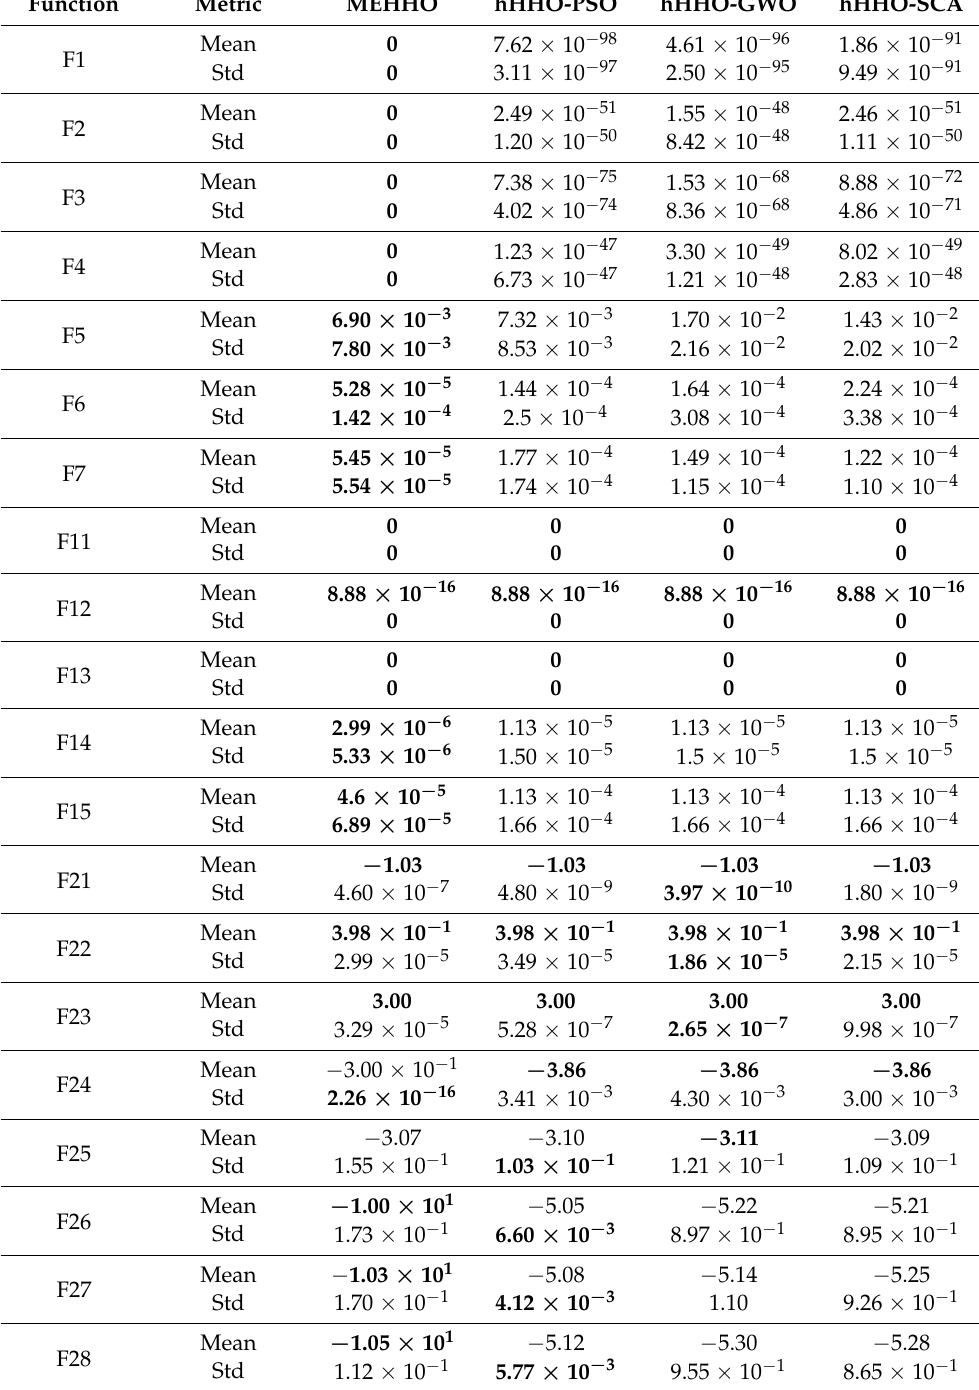
Table 13. Comparison of optimization results of four improved algorithms on common functions.